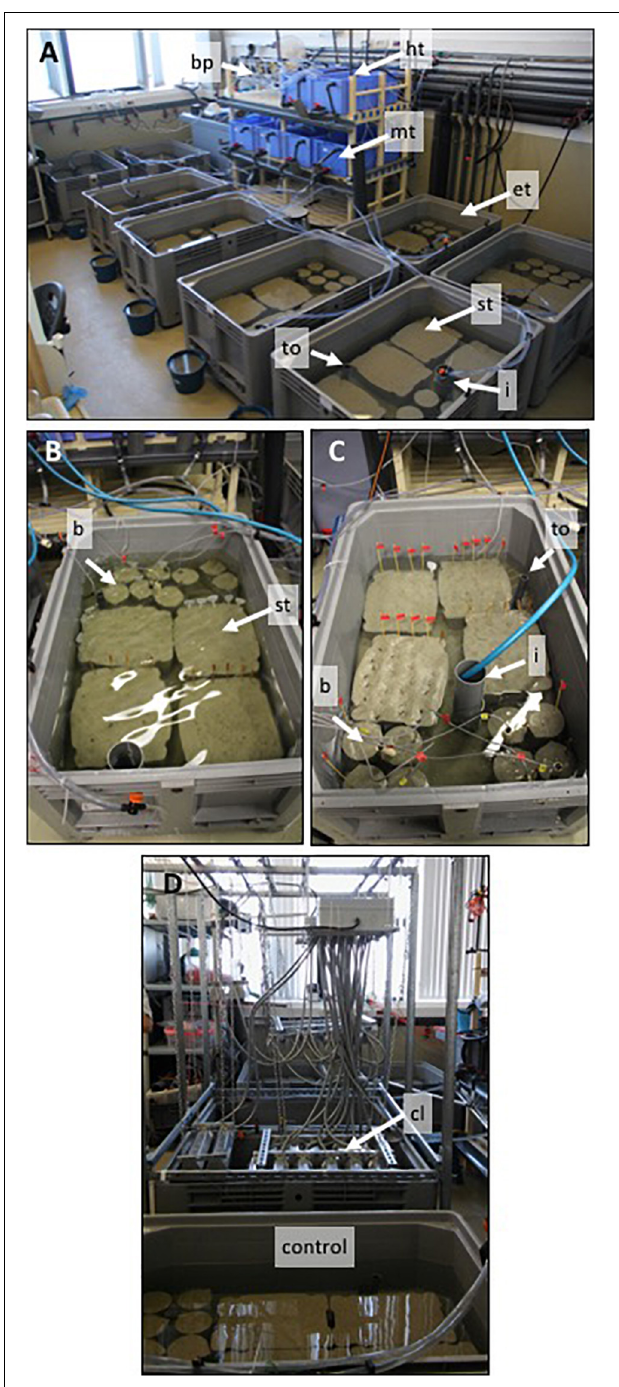
FIGURE 1 | Experimental design. (A) General setting for low salinity stress experiments. (B) Tank during high tide. (C) Tank during low tide. (D) General setting for heatwave stress experiment with the ceramic lamps in the position during low tide and control tanks. bp, dual bellows pumps; cl, ceramic lamps; et, experimental tanks; ht, head tanks with fresh and salt water; i, inlet; mt, mixing tanks for salinity treatments (S5, S10, S15, S30); to, outflow standpipe; st, 16 L species tanks (one per species). Plastic beakers (b) were used to study behavioral responses of the bivalves using pressure sensors; those results were published in Woodin et al.